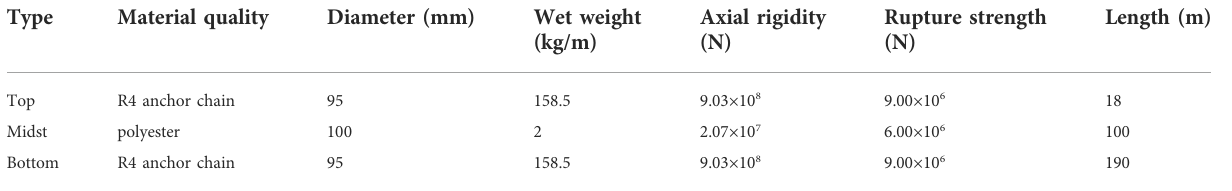
TABLE 1 Practical parameters of hybrid mooring cable scheme.